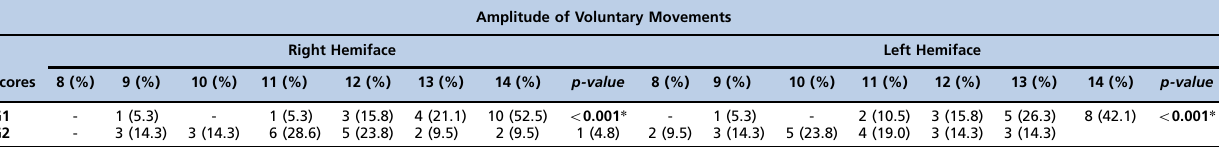
Table 3 - Evaluation of voluntary facial movements in deep partial-thickness burns – G1 (n=19) and full-thickness burns – G2 (n=21). Amplitude of Voluntary Movements Right Hemiface